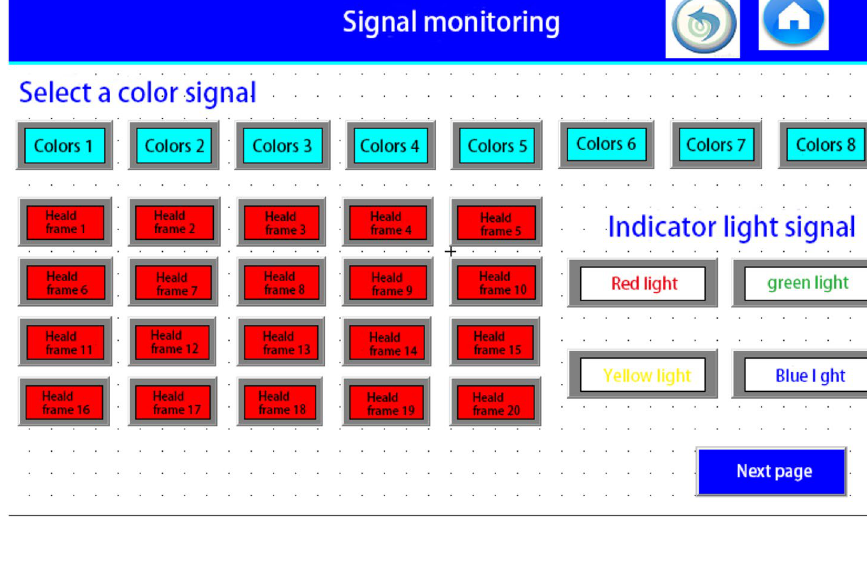
Fig. 24 Signal shielding